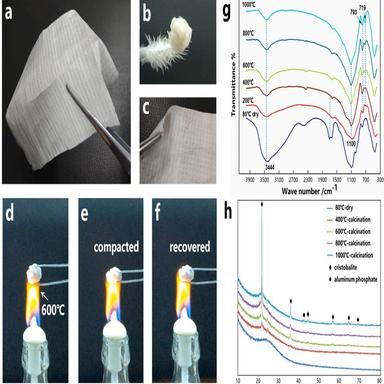
a–h Mechanical properties of the geopolymer nanofibers over a wide range of temperatures: (a) Actual image of the nano geopolymer mat; (b) The nano geopolymer placed on a feather; (d to f) Compression and recovery behavior of the nano geopolymer in an alcohol lamp treatment at approximately 600 ◦C; (g and h) FT-IR and XRD analysis results of the nano geopolymer after treatment at various temperatures.